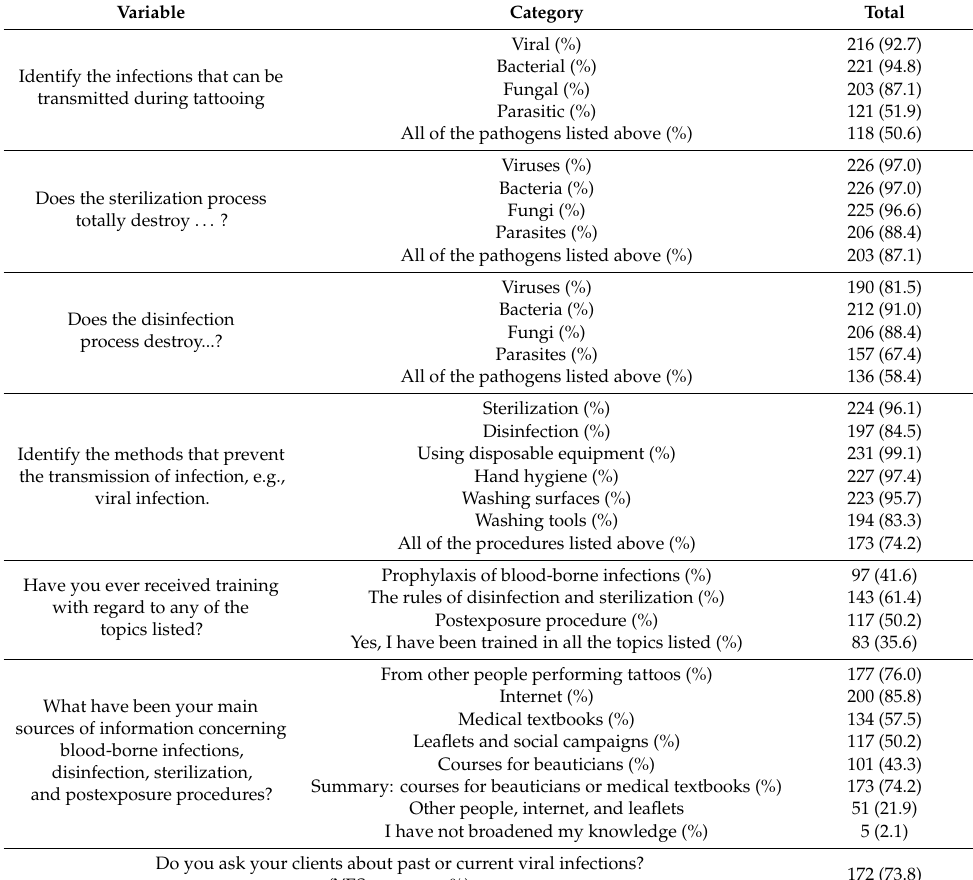
Table 1. Areas of relatively increased risk concerning detailed knowledge among